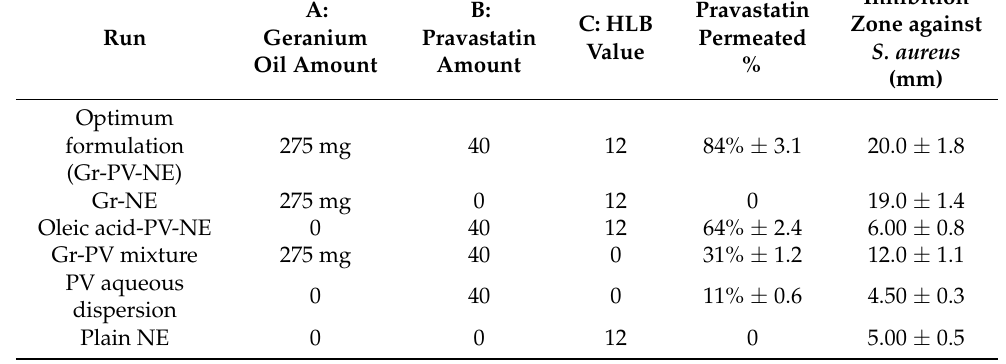
Table 4. Inhibition zones against S. aureus and percentage PV permeated for varying formulations.